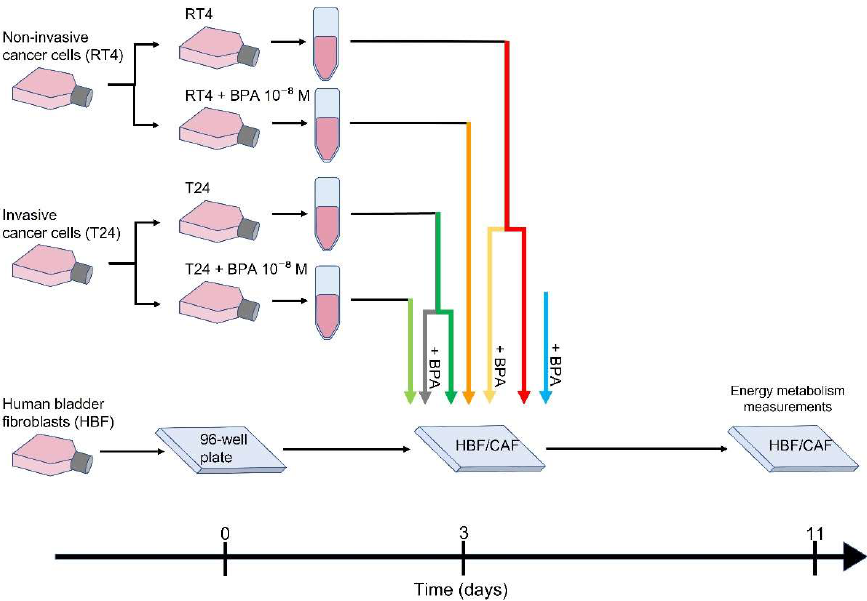
Figure 1. Experimental design. Non-invasive bladder cancer cells (RT4) and invasive bladder cancer